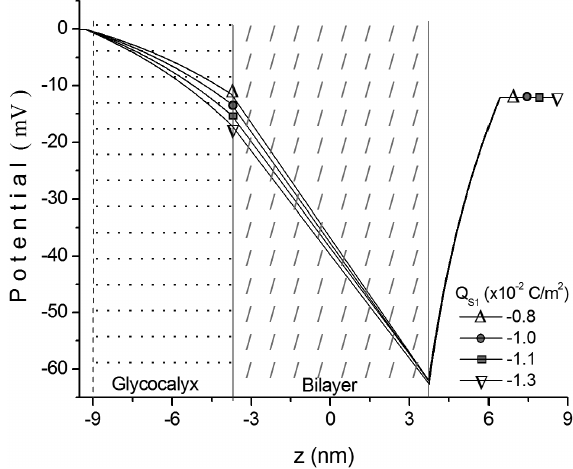
Figure 4 - Electric potential pro fi le for four values of ionic strength (F): F 0.5F , 0.25F and 0.1F (F is reference value, 1, 1 1 1 1 Table II), considering the situation B. Potential and charge density at S were estimated based on the model of Hsu et al. g (1996), Eqs. 18 and 19, using membrane values shown in Table I, and electrophoretic data given in Table II.